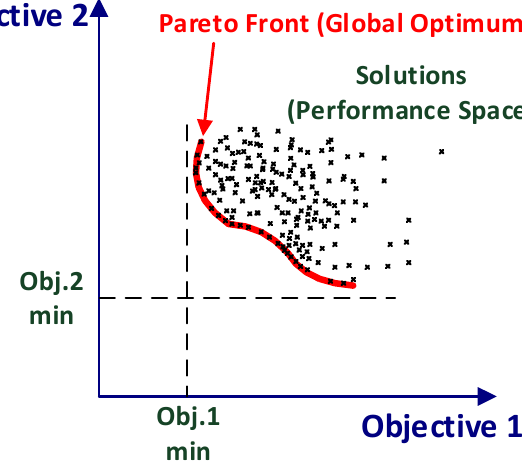
Fig. 3. Results of discrete optimization – Pareto Front (Global Optimum).